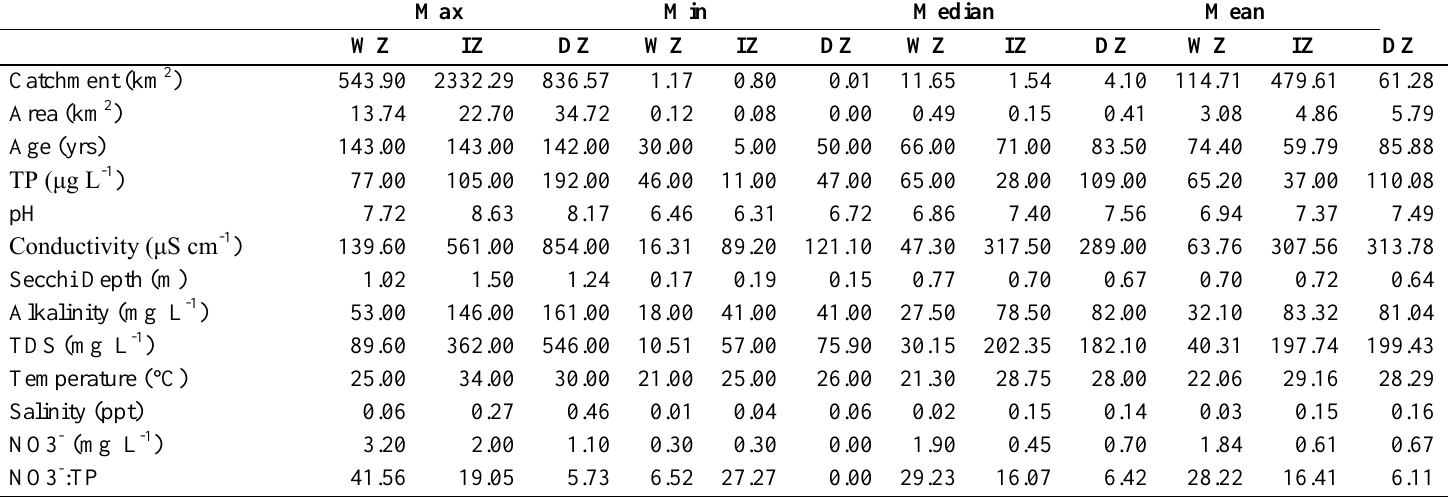
Table 1: Minimum, maximum, mean and median of Environmental data of our 45 study sites.